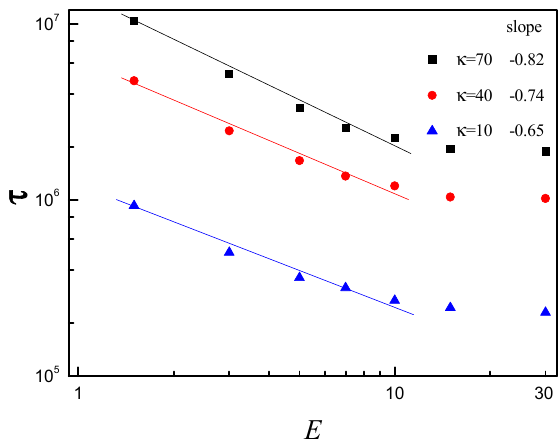
Figure 3. The average translocation time τ as a function of electric field strength E for bending stiffness κ = 10, 40 and 70. τ is obtained by averaging over the translocation times of 5000 samples. Data from R = 2 to 10 is plotted in log–log scale in Origin, and then the slope is obtained by the linear fit. The solid line is the linear fit of data from R = 2 to 10.